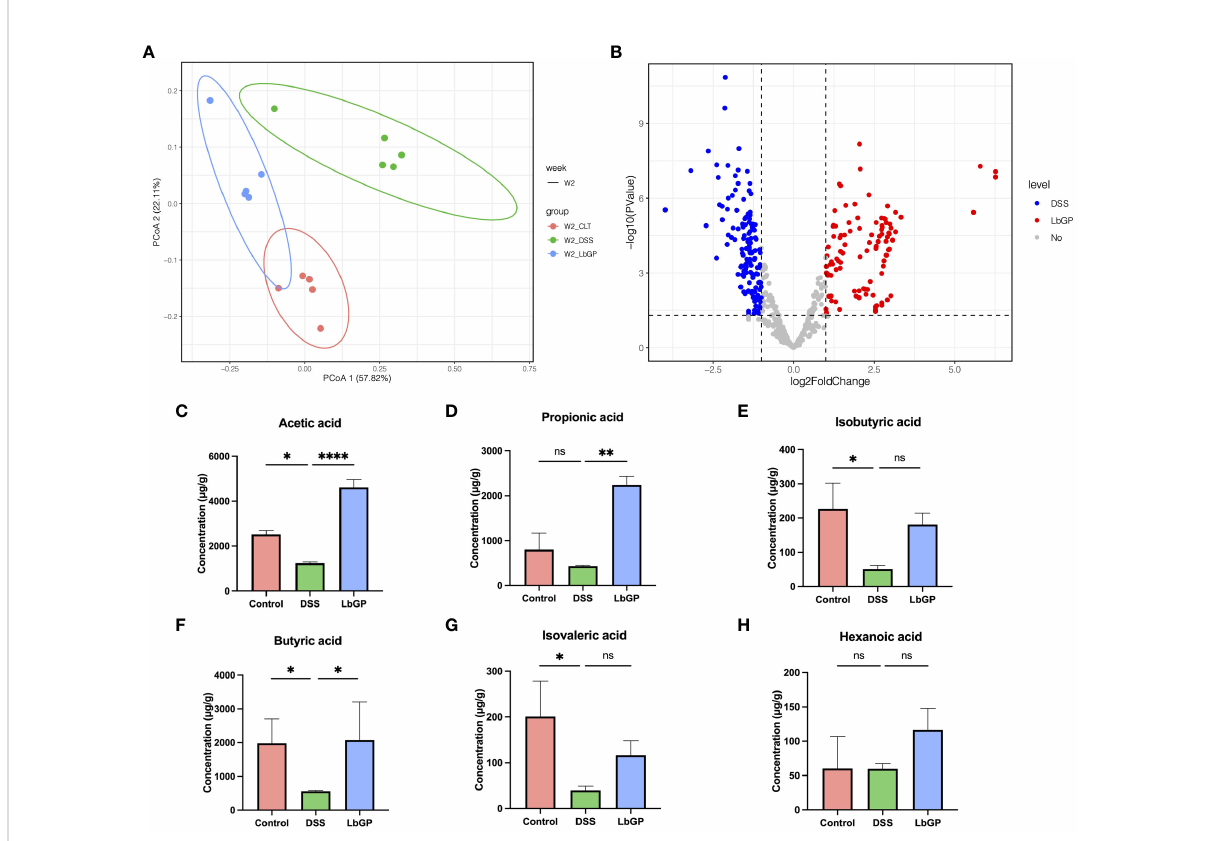
FIGURE 7 LbGP altered the function of gut microbiota. (A) PCoA analysis of metagenomic function based on the Bray-Curtis distance at W2. (B) Volcano plot of differential KOs between the DSS group and LbGP group at W2. (C – H) Concentrations of different SCFAs in mice colonic contents at W2. (n = 5, *P < 0.05, **P < 0.005, ****P < 0.0001). “ ns ” means “ no signi fi cant ”